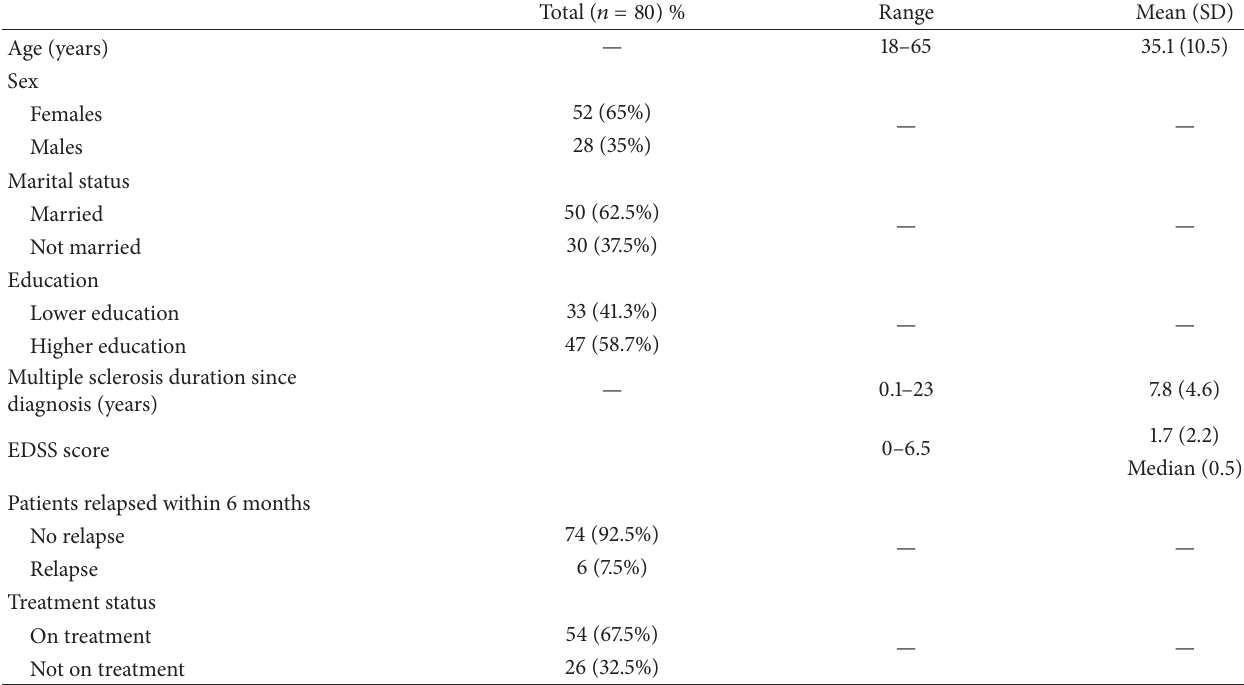
Table 2: Sociodemographic information and disease related